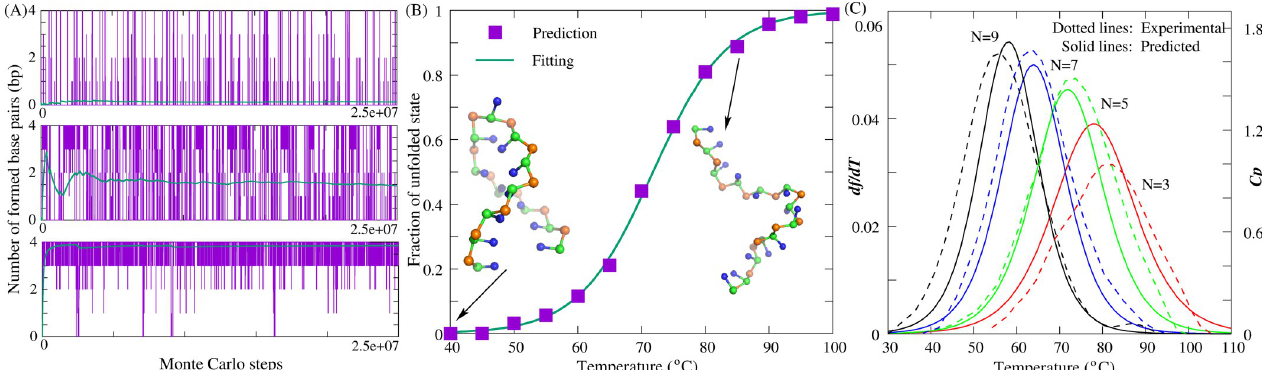
Fig 5. The stability predictions for ssDNA hairpins in the present model. (A) The time-evolution of the number of base-pairs for a simple hairpin (GCGC (T) 5 GCGC) at different temperatures (90˚C, 70˚C, 50˚C from top to bottom, respectively) in 0.1M NaCl solution. (B) The fraction of unfolded state f as a function of temperature for the hairpin in (A). Symbols: predictions from the present model. Line: fitted melting curve to the predicted data through Eqs 4–6. Ball-stick: the typical 3D structures predicted at low and high temperatures shown with PyMol (http://www.pymol.org). (C) The comparisons between predictions (solid lines) and experiments (dotted lines) for four DNA hairpins (GCGC(T) N GCGC) with different loop lengths at 0.1M [Na + ]. Red: N = 3. Green: N = 5. Blue: N = 7. Black: N = 9. df / dT : the first derivative of predicted f with the temperature. C p : the heat capacity from experiment [90].